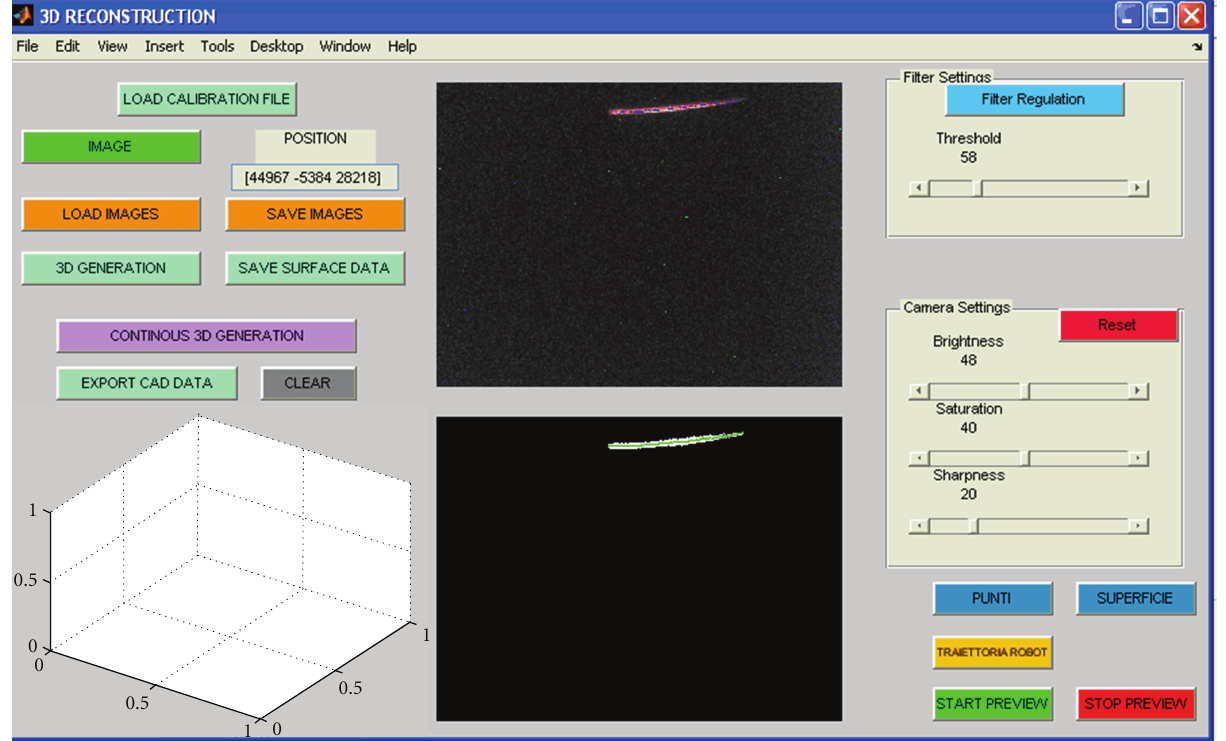
Figure 3: Graphical user interface to control system